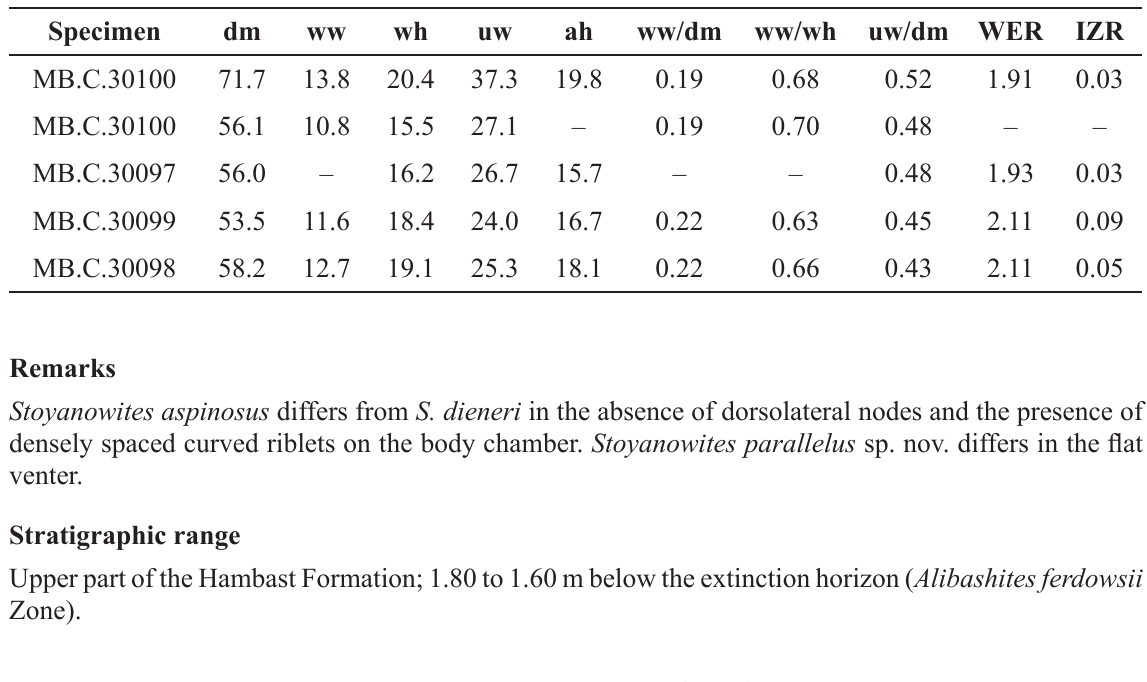
Table 36. Conch dimensions (partly estimated) and ratios of selected specimens of Stoyanowites aspinosus Korn & Ghaderi in Korn et al. , 2016 from Baghuk